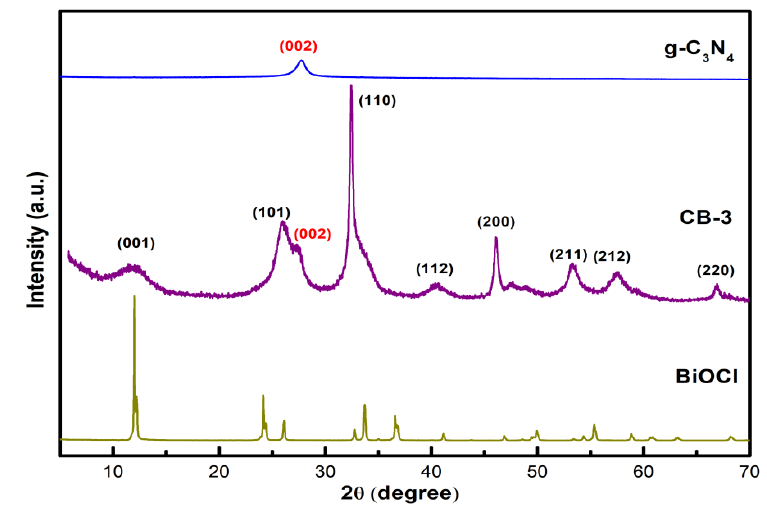
Figure 2. XRD patterns of g-C 3 N 4 , CB-3 and BiOCl.